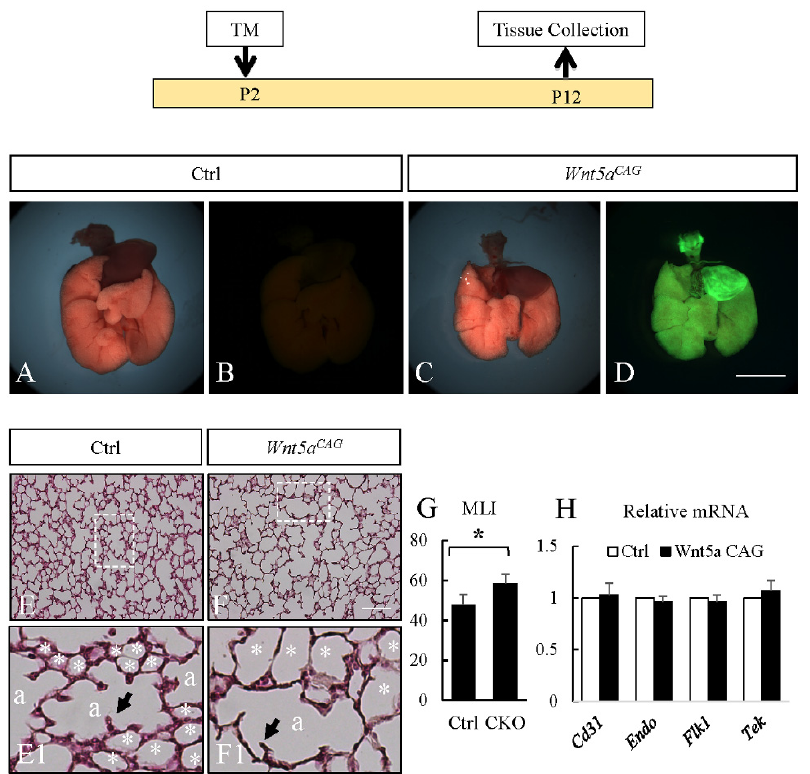
Figure 3. Postnatal inactivation of Wnt5a attenuates alveologenesis. Top: Schematic of the experimental plan. A – D: Gross morphology of P12 control ( A – B ) and Wnt5a CAG ( C – D ) lungs. Panels A and C show bright-field images. Panels B and D show green fluorescent images of control and Wnt5a CAG embryos, respectively. Scale bars ( D ): 4 mm for A – D . E – F: H&E staining of P12 control ( E ) and Wnt5a CAG ( F ) lungs. E1 and F1 show higher magnification views of boxed areas (rotated 90 degree clockwise in E1) in E and F, respectively. Please note that distal alveolar units (*) surrounding the dividing alveolar space (a) are profoundly enlarged in the mutant lungs. Arrows indicate 2nd crests. Scale bars ( F ): 100 µ m for E and F ; 25 µ m for E1 and F1. G : Mean linear intercept (MLI) of control and Wnt5a CAG lungs (CKO). H : Relative mRNA for endothelial markers in Wnt5a CAG lungs (Wnt5a CAG, P12-13) compared to the littermate control lungs by real-time RT-PCR analysis. Data represent the mean ± SEM. * indicates p < 0.05. n = 4.